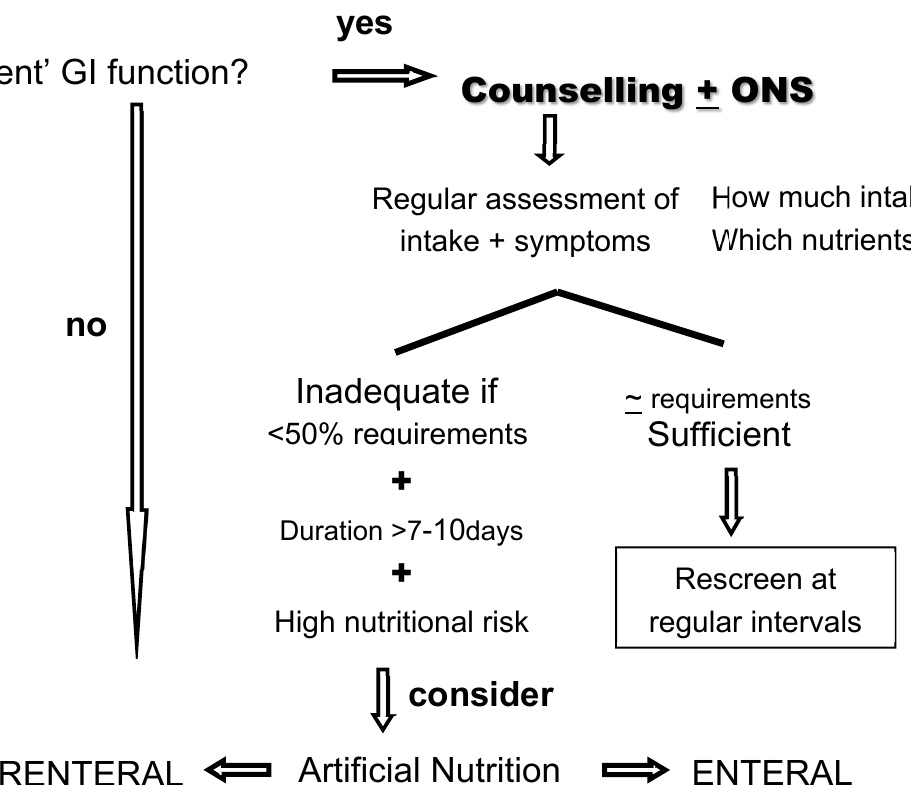
Figure 1. Evidence based decision making plan